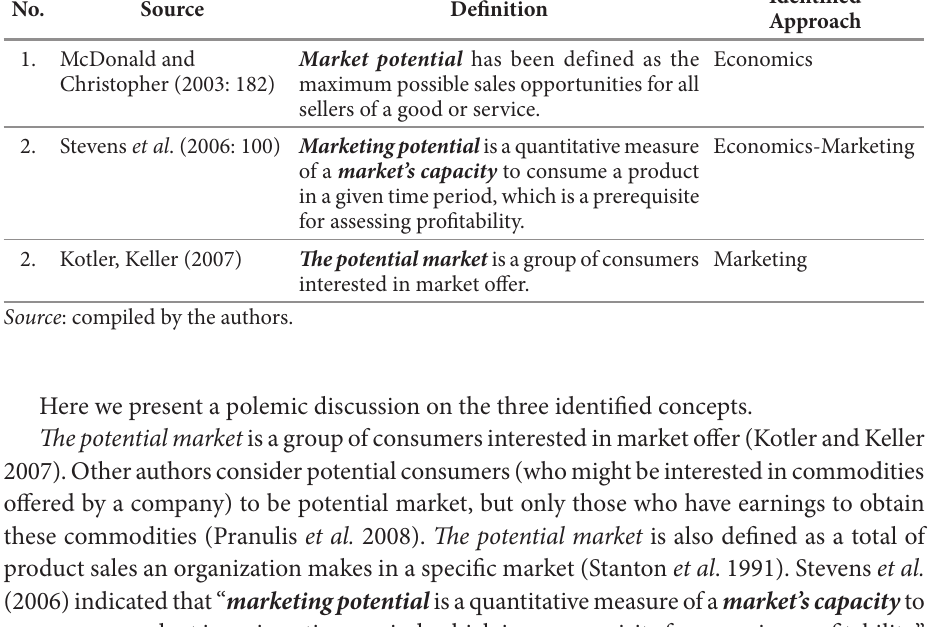
Table 1. Selected definitions on market potential